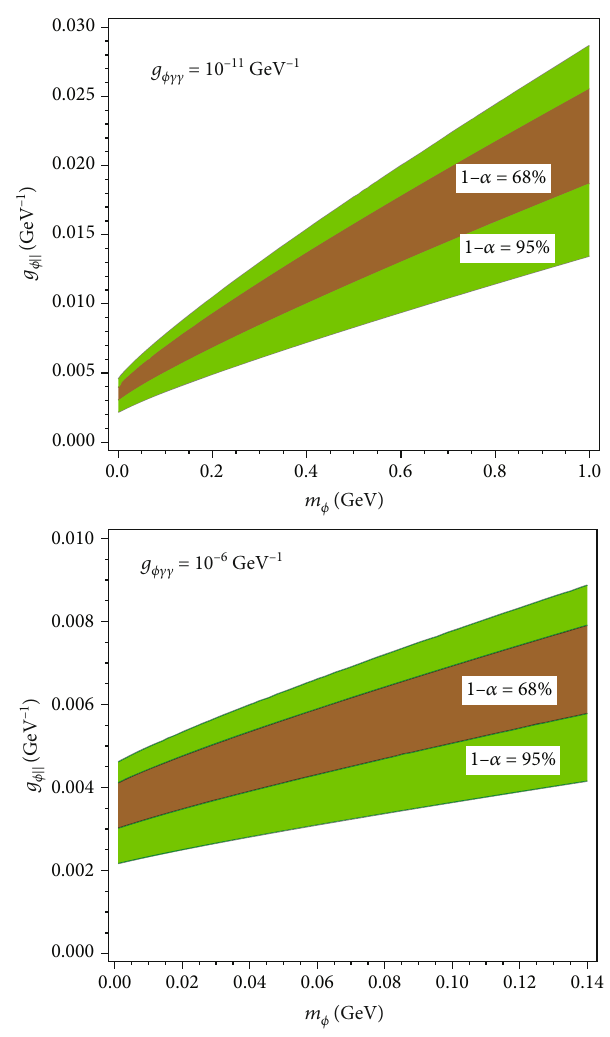
− g ϕ ϕ ll parameter space of the